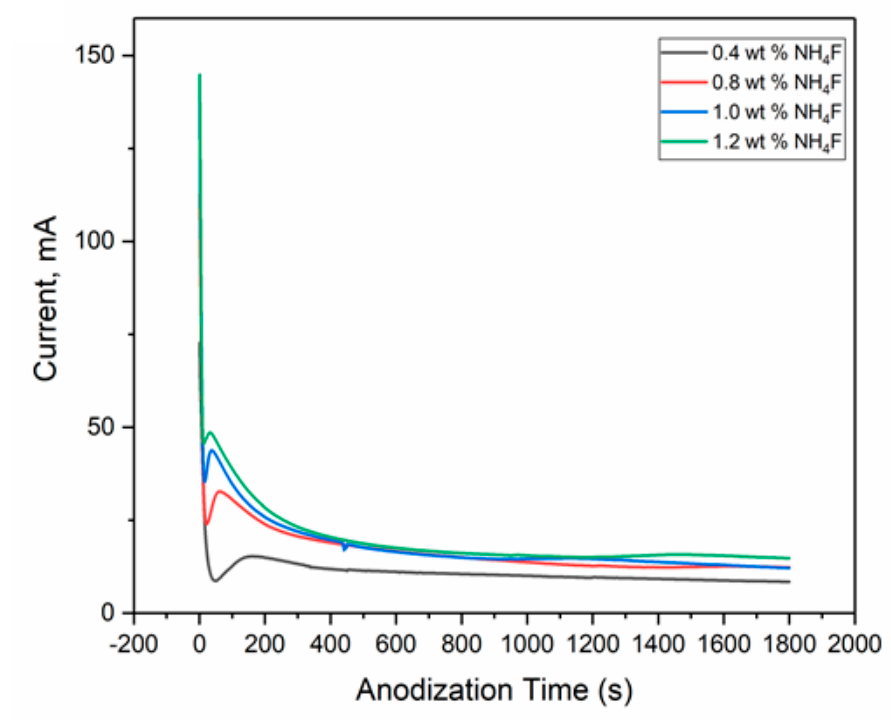
Figure 3. Current–time response during the anodization process using different electrolyte concentrations (anodization time: 30 min, anodization voltage: 30 V).